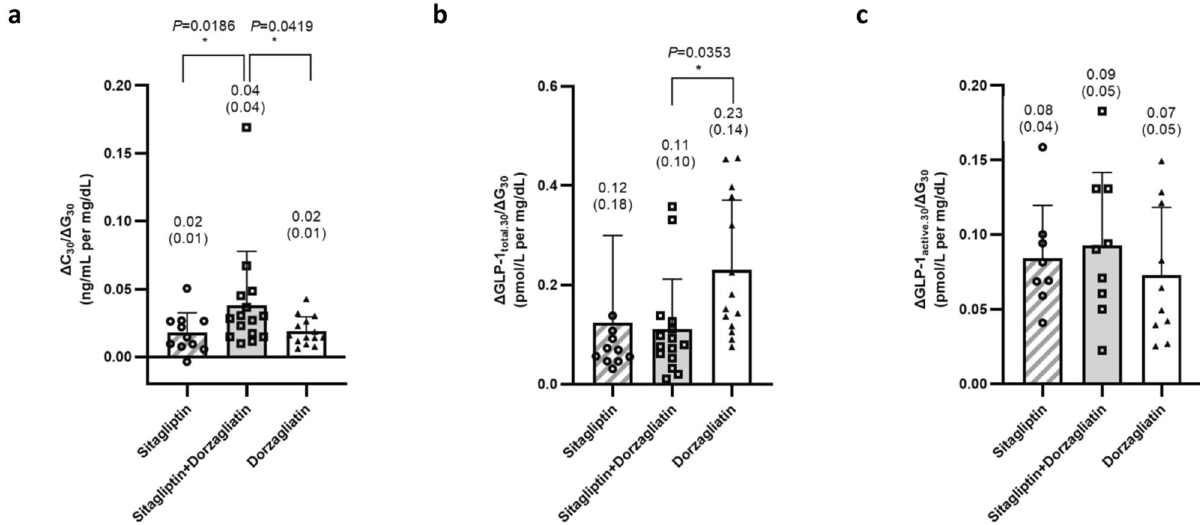
Fig. 2 | Glucose sensitivity. a The insulinogenic index ( Δ C 30 / Δ G 30 ) (sitagliptin, n =11; sitagliptin+dorzagliatin, n =15; dorzagliatin, n =14), b total GLP-1 secretion index ( Δ GLP-1 total.30 / Δ G 30 ) (sitagliptin, n =11; sitagliptin+dorzagliatin, n =15; dor- zagliatin, n =14), and c active GLP-1 secretion index ( Δ GLP-1 active.30 / Δ G 30 ) (sita- gliptin, n =8; sitagliptin+dorzagliatin, n =9; dorzagliatin, n =10) are calculated based on the C-peptide and GLP-1 levels in the OGTT study. A diagonal bar and empty circles represent the mean and individual index under sitagliptin